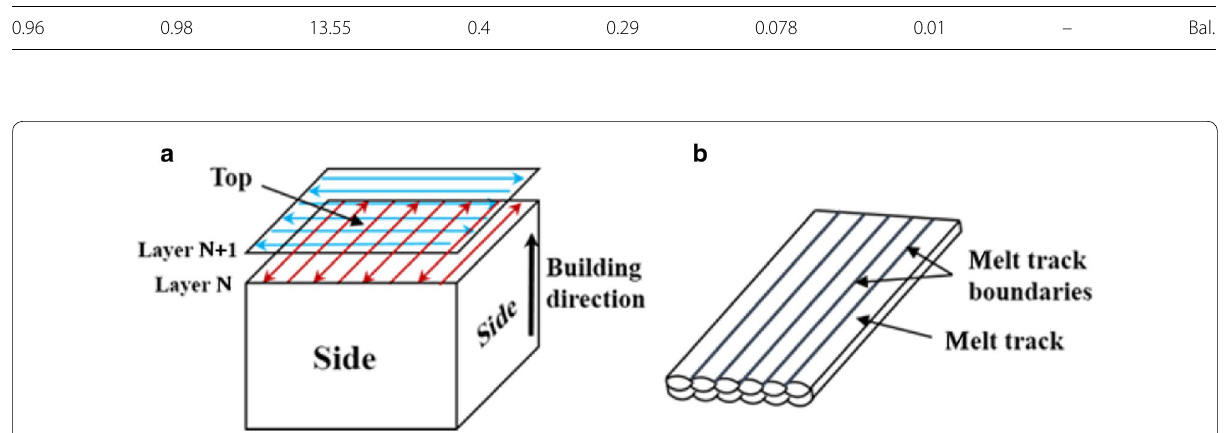
Figure 2 a Illustration of the laser scanning strategies; b melt track and melt track boundaries